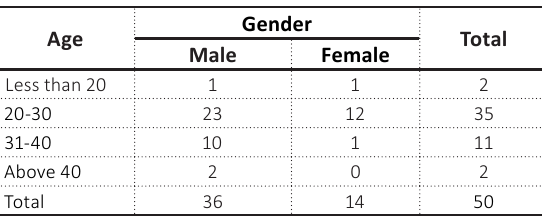
Table 2. Age and gender distributions of